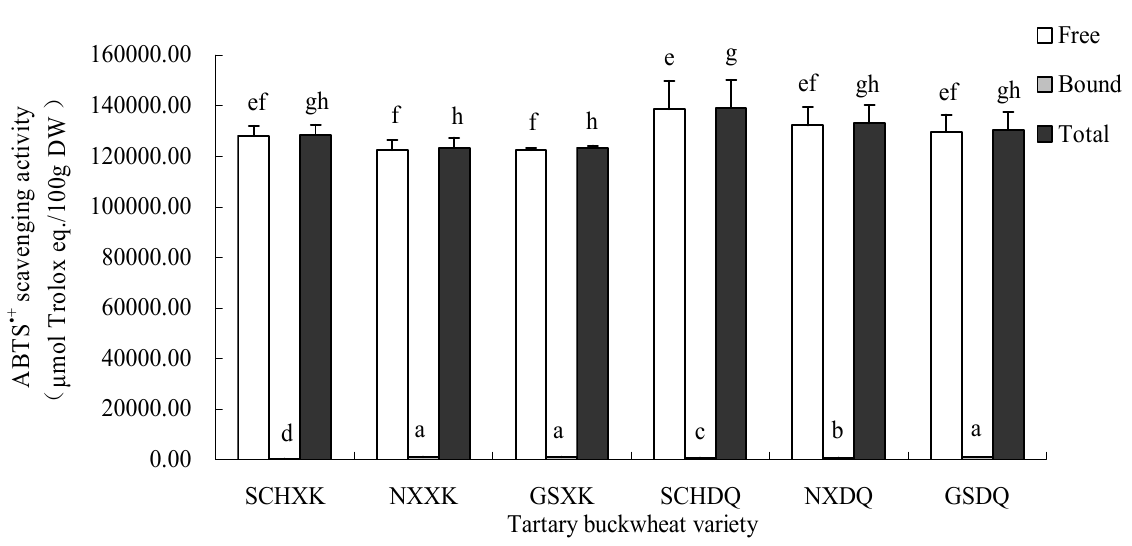
SCHXK, NXXK and GSXK represent Xingku No.2 grown in Sichuan, Ningxia and Gansu respectively, SCHDQ, NXDQ and GSDQ represent Diqing grown in Sichuan, Ningxia and Gansu, respectively. The error bars represent the standard deviation ( n = 3). Values marked by the same letter are not significantly different ( P < 0.05). Figure 2. ABTS  + scavenging activity of two tartary buckwheat varieties grown at 3 locations ( μ mol Trolox eq /100g DW).